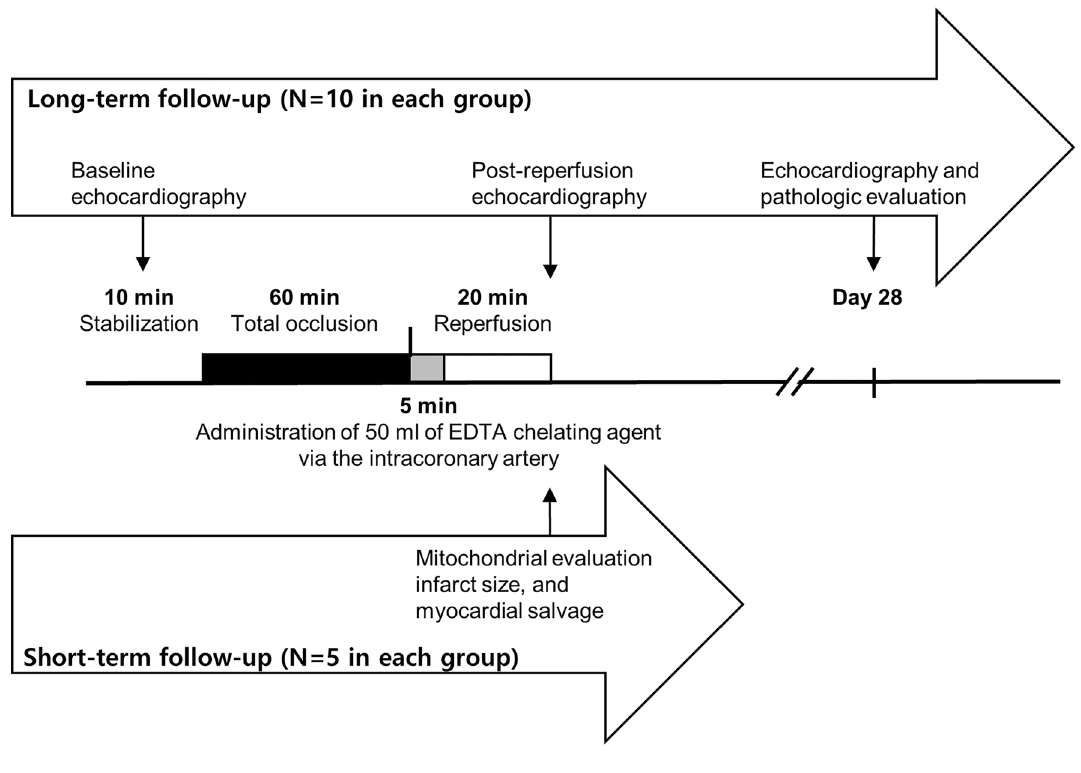
Figure 3. Schematic study